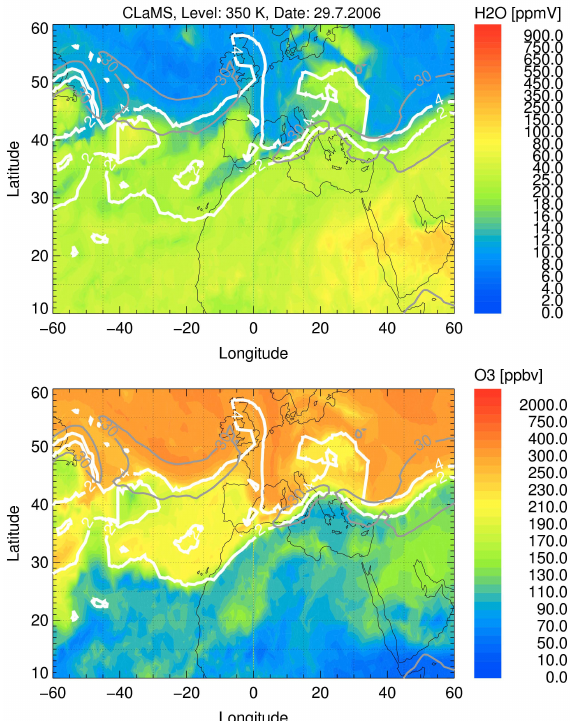
Fig. 1. Map of CLaMS H 2 O and O 3 on the ζ =350K level with 2 and 4PVU line (white, solid) and horizontal wind speed of 30ms − 1 from ECMWF (grey, solid) marking the position of the subtropical jet.